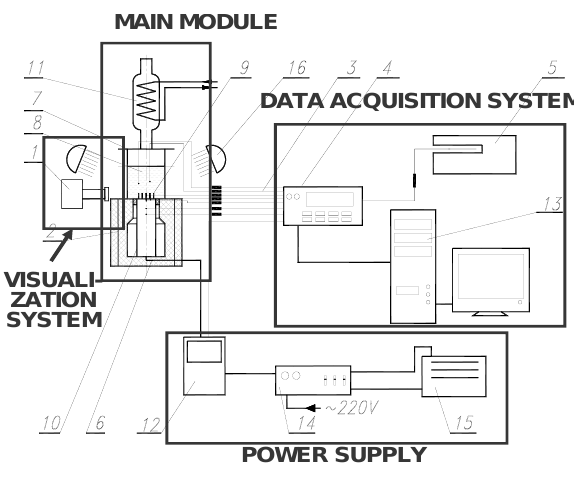
specimen with microchannels.